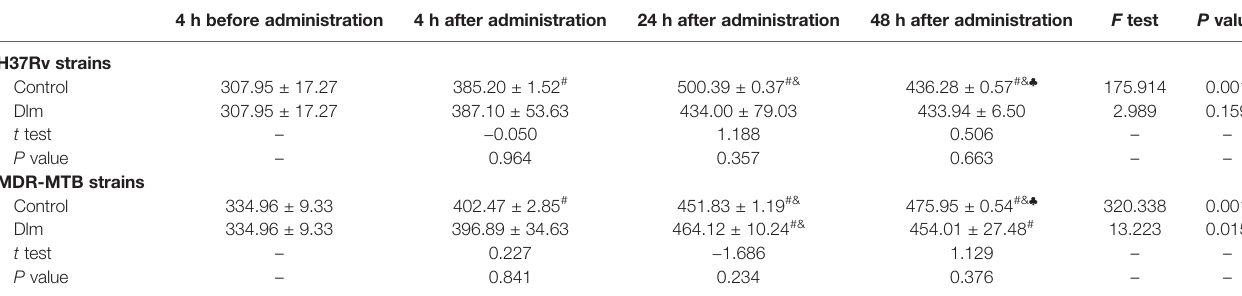
TABLE 3 | The level of TNF- a in the culture supernatant of macrophages infected by MDR-MTB after Dlm was administered (pg/ml, (cid:1) x ± s ).